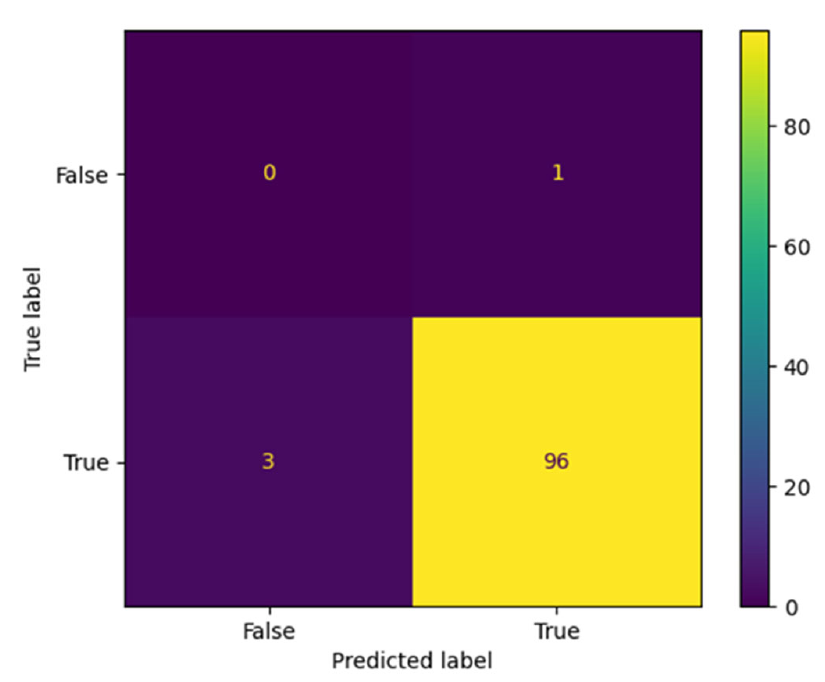
Figure 11. Confusion matrix obtained by AraBERT on the Mobily dataset.